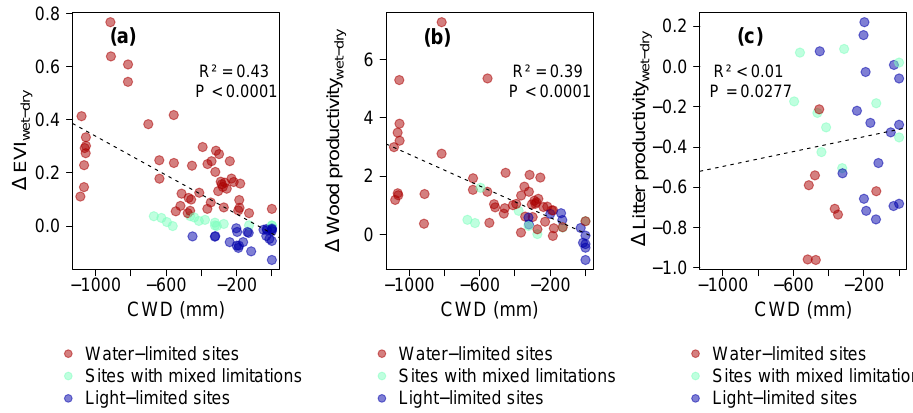
Figure 11. Associations between site’s (cid:49) EVI wet-dry (a) , (cid:49) wood productivity wet-dry (b) and (cid:49) litter productivity wet-dry (c) with the environmental variable maximum climatological water deficit (CWD). Dashed lines are the regression lines. (cid:49) EVI wet-dry , (cid:49) wood productivity wet-dry and (cid:49) litter productivity wet-dry indices are the differences of mean of the wet- and dry-season of the variable normal- ized by the annual mean, where dry season is defined as months with potential evapotranspiration above precipitation (Guan et al., 2015). For the sites where evapotranspiration is never above precipitation, dry season is defined as months with normalized potential evapotranspiration above normalized